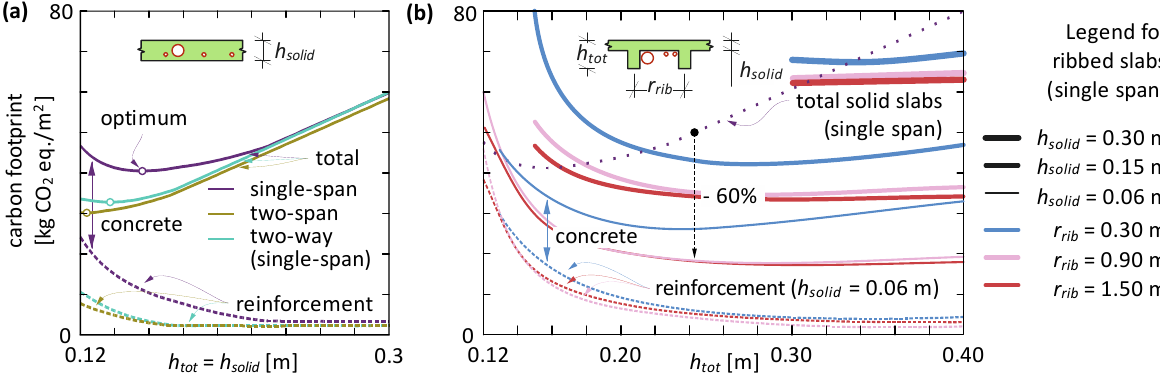
Figure 3 . Carbon footprint of concrete and reinforcement (dashed lines) of (a) solid slabs (single ‐ span, two ‐ span, and two ‐ way single ‐ span) and (b) single ‐ span ribbed slab (both spanning 6 m) as a function of its total